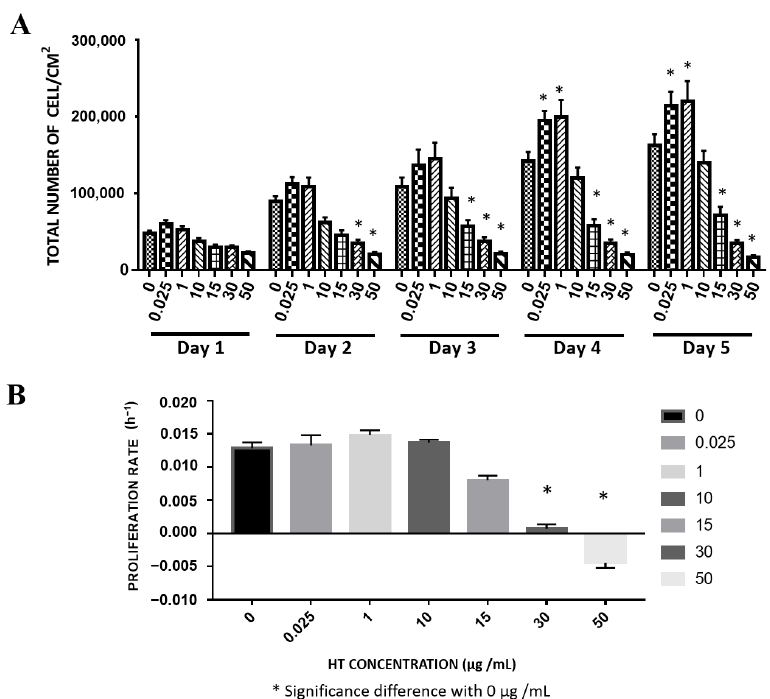
Figure 2. Long-term effect of HT supplementation on RECs. ( A ) Total number of cells attached vs. HT concentration. ( B ). Proliferation rate. * p < 0.05: significantly different from control (Supplementary Material Table S2).